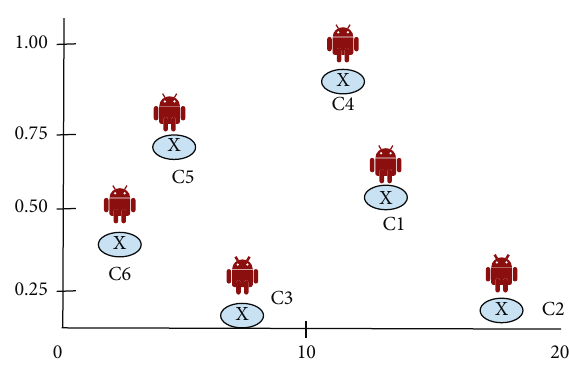
Figure 15: Probability assignment of malicious APK clusters. Table 9: Probability assignment for each application topic-wise.